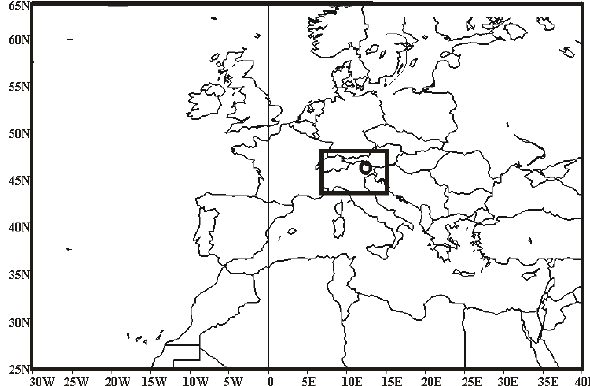
Figure 2. Nested view of study domains including the synoptic scale (the full domain as outline by the outer rectangle), meso- α scale (denoted by the smaller rectangle encompassing northern Italy), and meso- β scale (the smaller circle surrounding the debris flow source region). The debris flow basins for each of the 12 events are located in the meso- β scale analysis